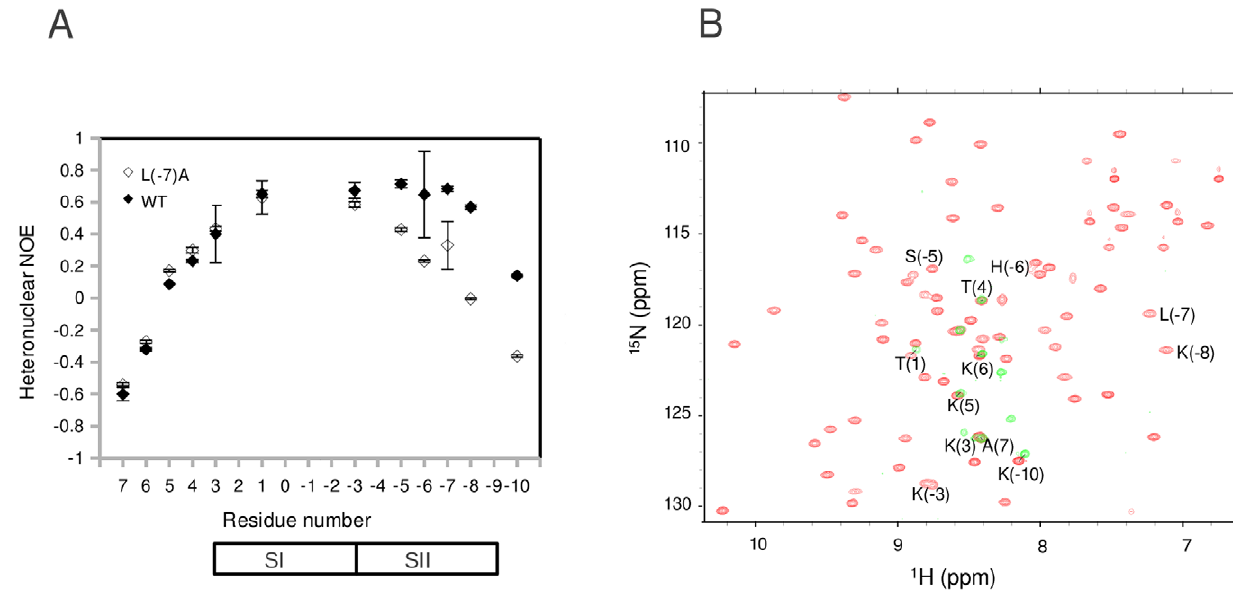
Figure 4. Analysis of peptide dynamics in WT and mutant peptide complexes. (A) Analysis of L( 2 7)A peptide complex reveals a partially bound and dynamic peptide. 15 N- 1 H NOE values for AbpSH3-bound ArkA (filled diamonds) and AbpSH3-bound L( 2 7)A (empty diamonds) show that there is significant dynamics in the C-terminal part of the peptide for the L( 2 7)A complex. The bars at the bottom of the graph indicate which positions of the peptide bind SI or SII. (B) 2D NH correlation spectrum of AbpSH3-ArkA complex (both protein and peptide in red) and AbpSH3-ArkA L( 2 7)A complex (only peptide is shown in green). The ArkA peptide resonances are labeled. The N-terminal half of ArkA L( 2 7)A peptide has NH chemical shift values close to WT (see positions 6, 5, 4, 3 and 1 and the lines that connect the resonances), while the C-terminal half has NH chemical shift values different to WT (see positions 2 3, 2 5, 2 6, 2 7 and 2 8) and several are clustered in the center of the spectrum.